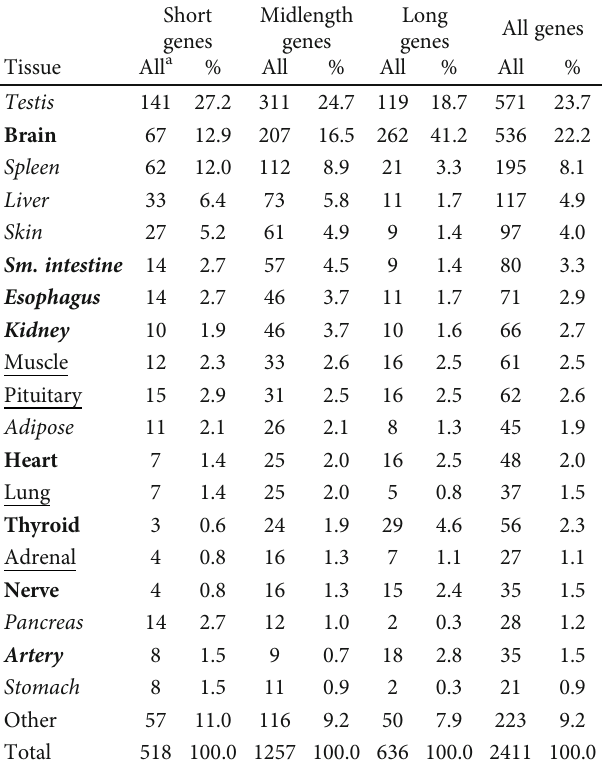
Table 2: Tissue speci fi city of genes in the tissue-targeted database.